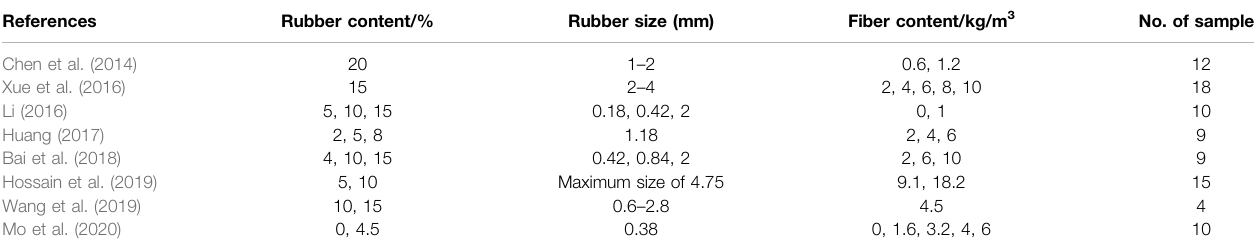
TABLE 8 | 87 groups of rubber fi ber concrete ’ s test data sets.